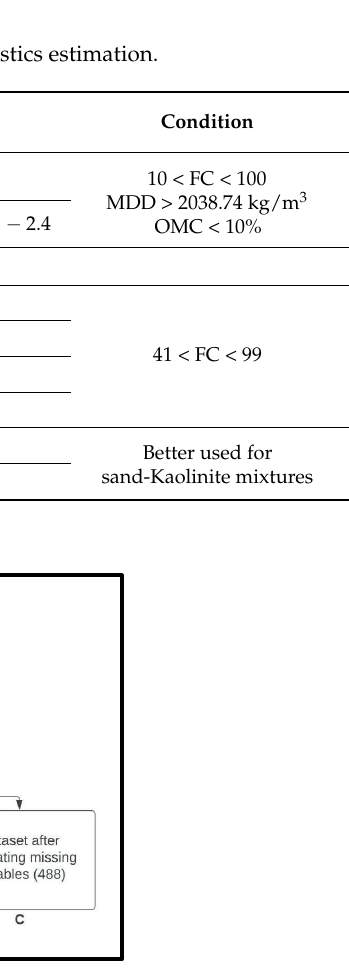
Figure 2. Dataset categories and their associated numbers of data points. Table 6. Descriptive statistics of the input variables . Table 6 displays the data statistics for the input variables. The data were analyzed based on the three scenarios, and the results are compared.